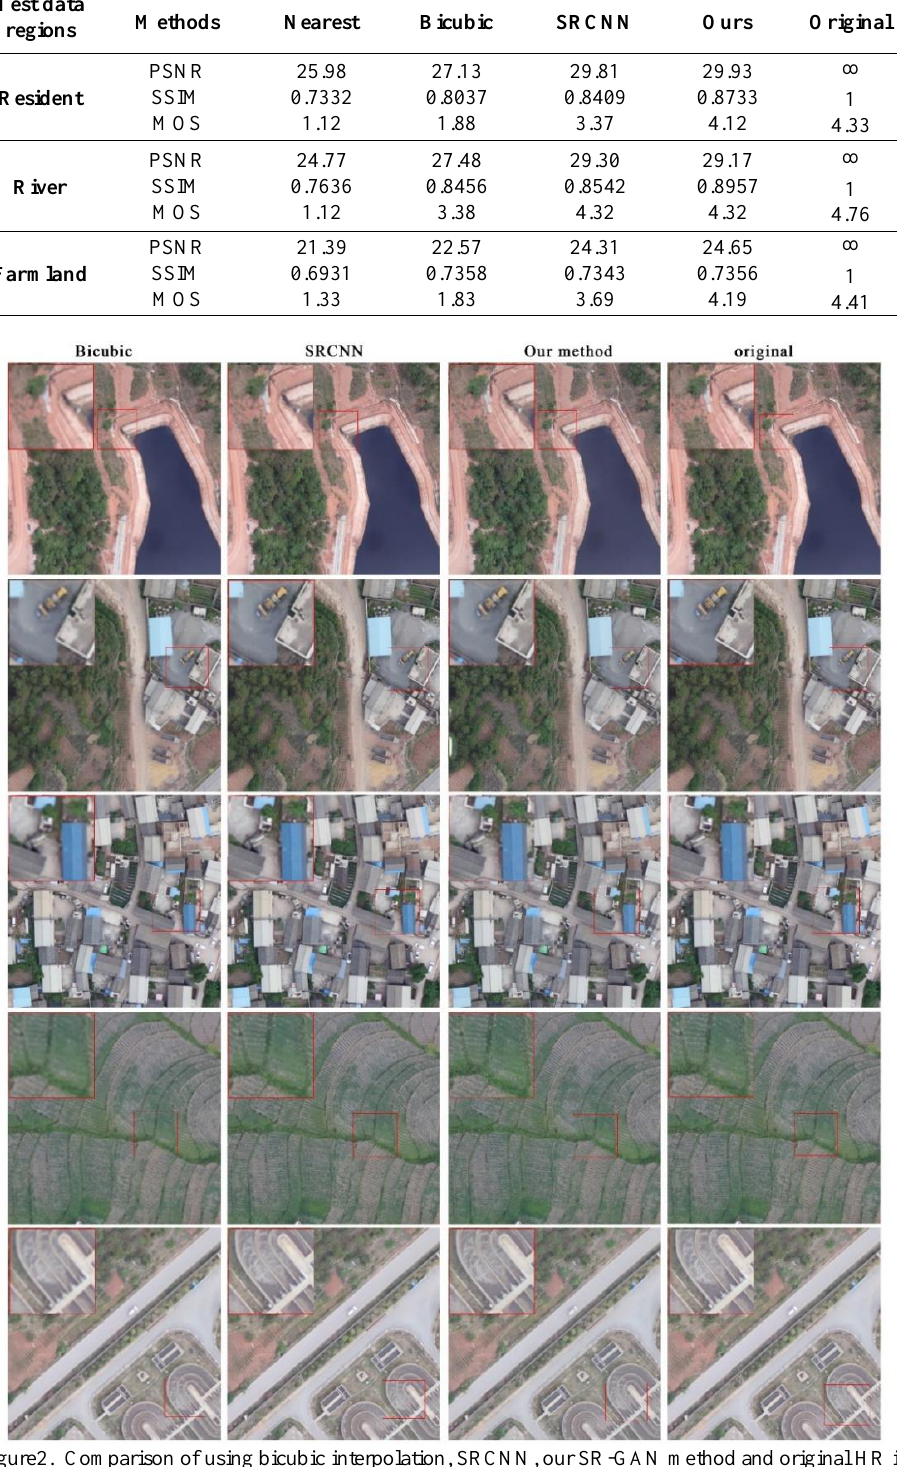
Table 2. Comparison of NN, bicubic, SRCNN, our method and original HR on GF2 satellite image.